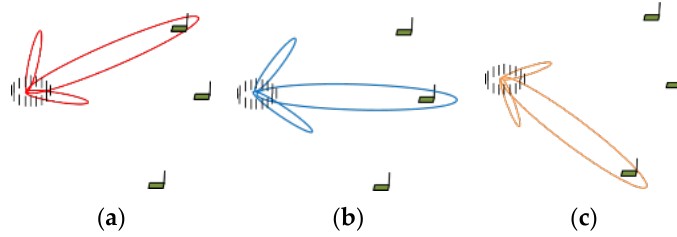
Figure 1. An antenna array can steer the strongest energy beams to aim at different directions, e.g., directions to the ( a ) upper right sensor; ( b ) rightmost sensor; and ( c ) lower right sensor.